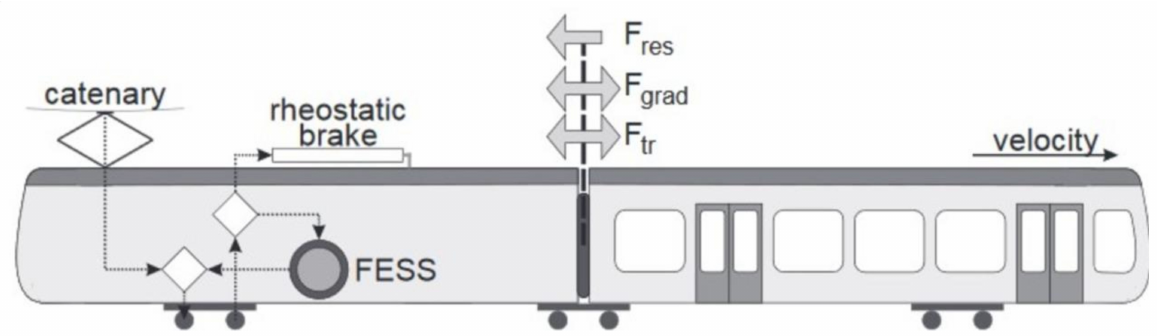
Figure 17. Flywheel energy storage system in rail transport, reproduced with permission from